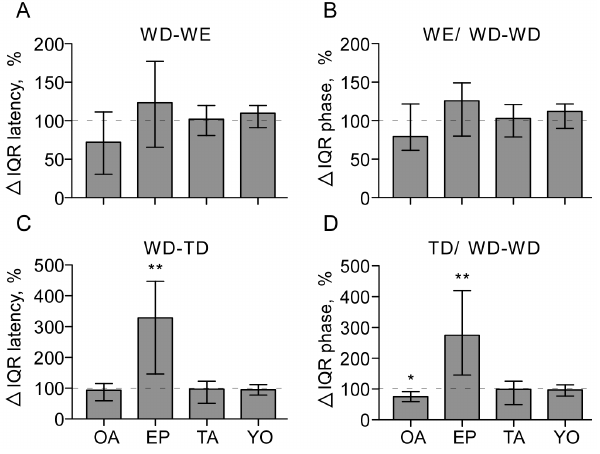
Figure 11. Relative changes (%) in the degree of temporal coupling between different motor units (evaluated as in Fig. 6) for wind evoked fictive flight following treatment with (from left to right): octopamine (OA, 5 mM), the octopamine receptor antagonist epinastine (EP, 1 mM), tyramine (TA, 5 mM) and the tyramine receptor antagonist yohimbine (YO, 1 mM). Data from same preparations as for Fig. 9. A WD-WE latency, B phase of wing elevator in wing depressor cycle (WE/WD-WD), C WD-TD latency (coupling of leg unit TD to the wing unit WD), D phase of leg unit in wing depressor cycle (TD/WD-WD). Columns give the median, ticks the IQR and asterisks significant differences (Wilcoxon Signed Rank test *p , 0.05, **p , 0.01).